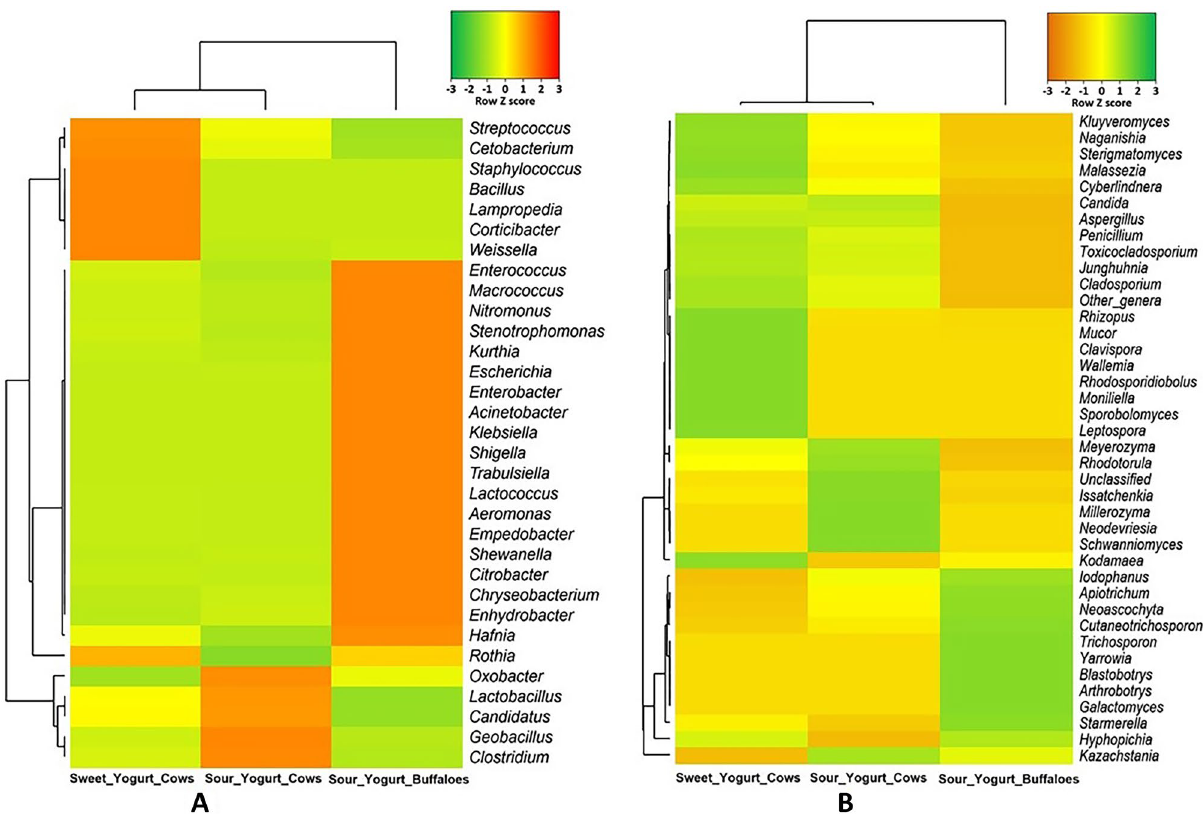
Figure 5. Genus level taxonomic differentiation of bacteria and fungi in sweet yogurt (from cow milk) and sour yogurt of cow and buffalo milk. Heatmap showing 40 top abundant bacterial genera across the sample categories. The color bars (column Z score) at the top represent the relative abundance of each ( A ) bacterial genus and ( B ) fungal genus in the corresponding group. Noteworthy differences in bacterial and fungal populations are those where the genus is abundant in either sweet or sour yogurt samples, and effectively not detected in other metagenomes. The color codes indicate the presence and completeness of each genus in the corresponding sample group, expressed as a value between − 3 (lowest abundance) and 3 (highest abundance). The red color indicates the more abundant patterns, while green cells account for less abundant putative